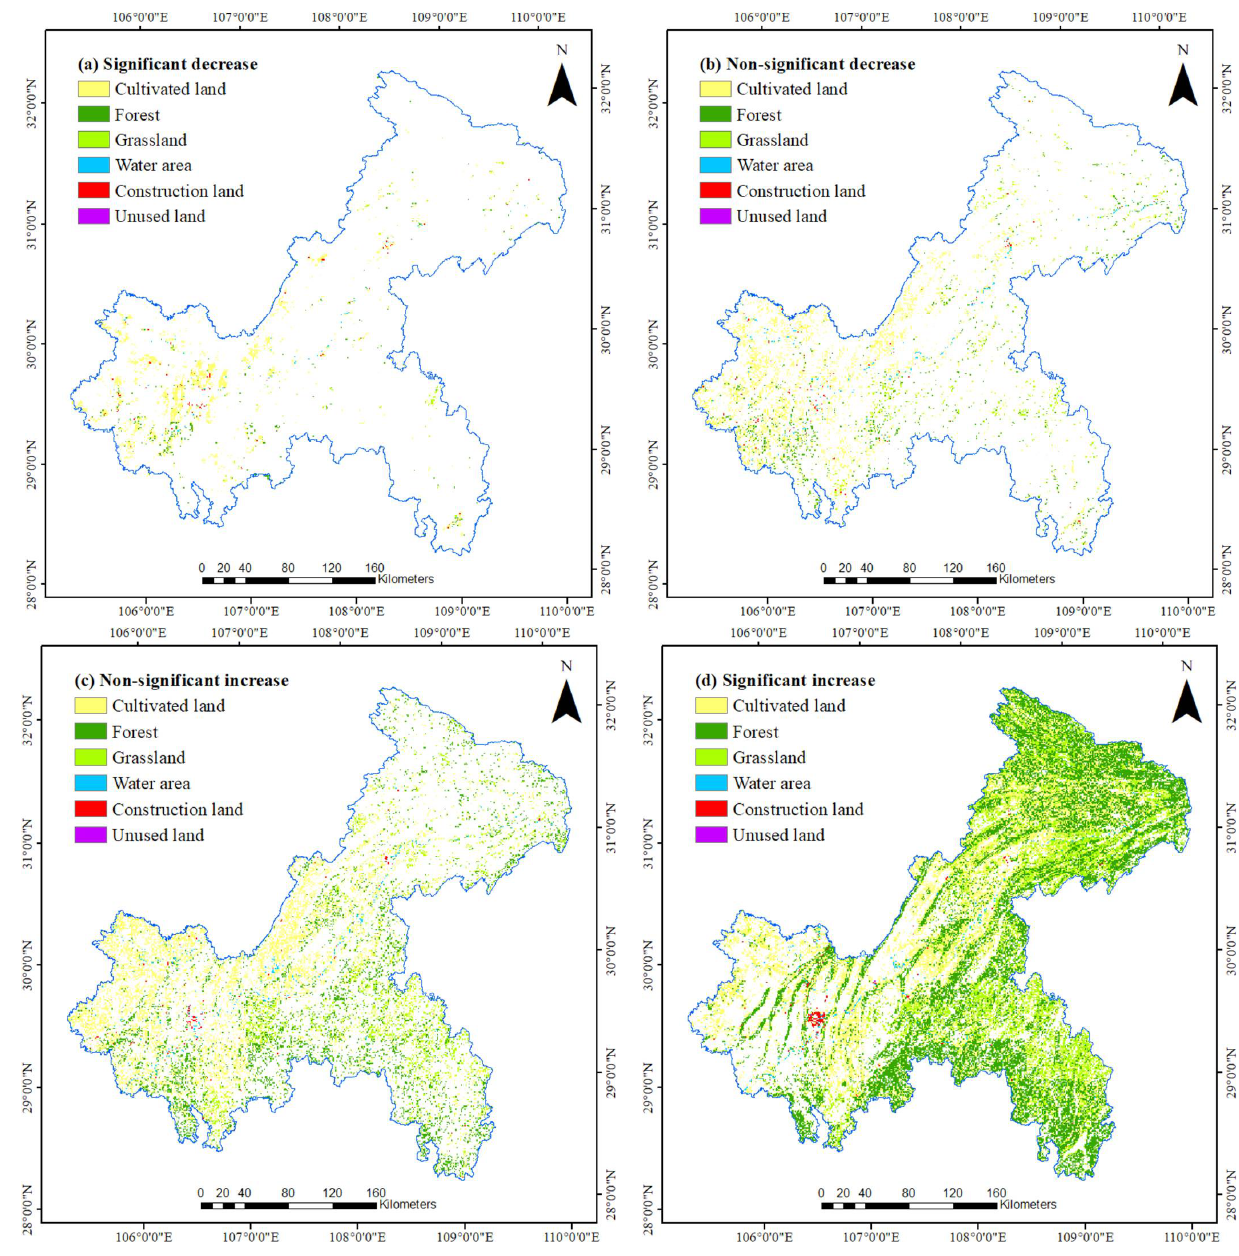
Figure A4. Spatial distribution of land use types in different regions in 2000: ( a ) significant decrease, ( b ) non-significant decrease, ( c ) non-significant increase, and ( d ) significant increase.